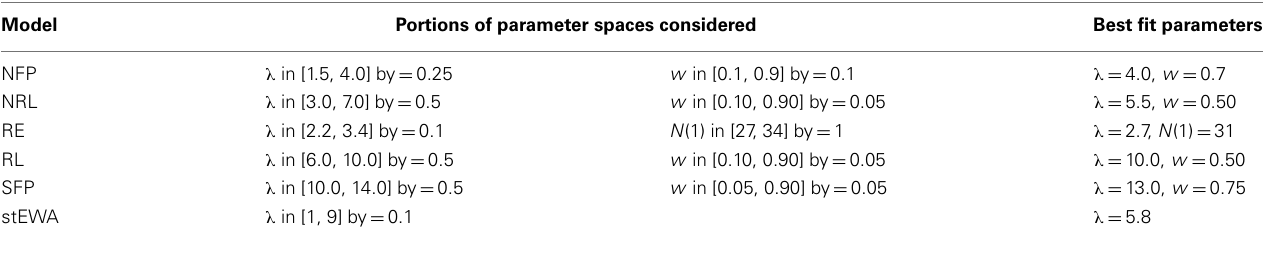
Table 2 | Explored portions of parameter spaces and the parameter configurations yielding the lowest average MSD in the two experiments.